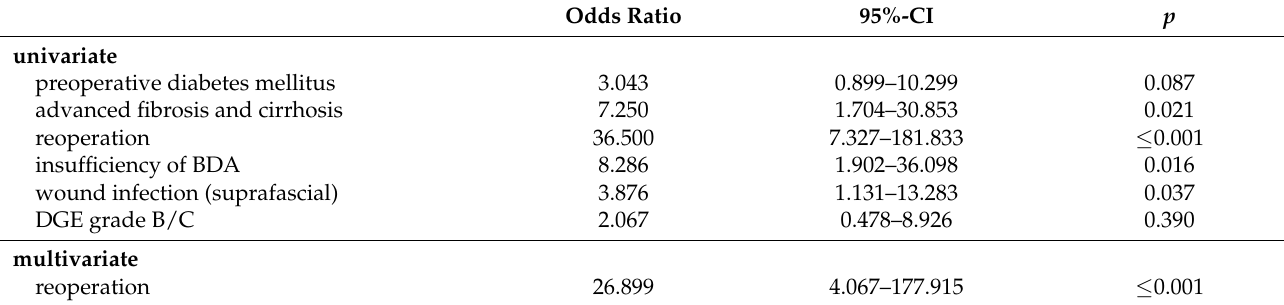
Table 4. Risk factors associated with high